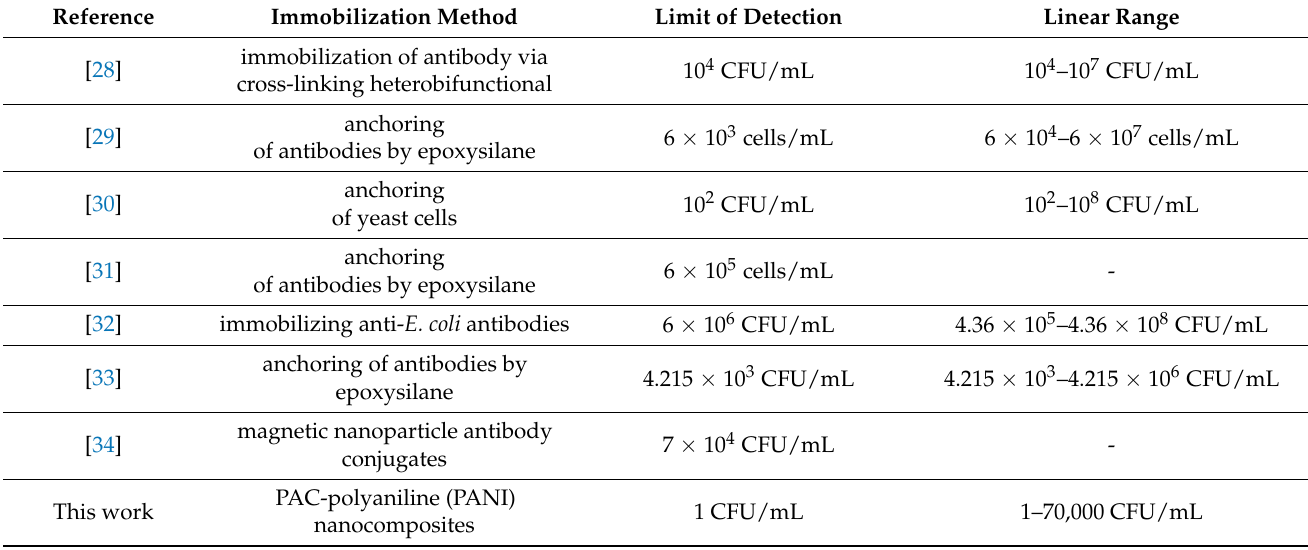
Table 2. Comparison between the proposed method and bacterial biosensors reported.